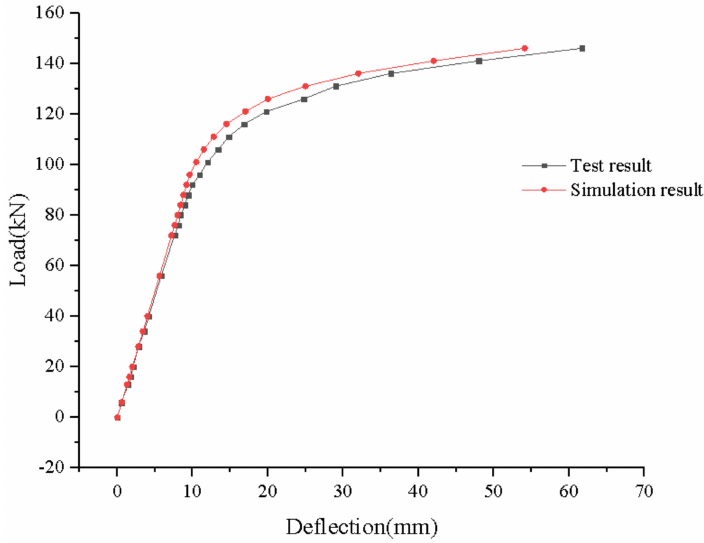
Figure 15. Load–deflection curve of composite floor in midspan.